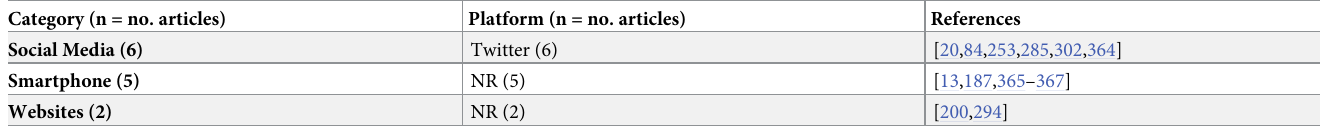
Table 17. Number of articles predicting income, with associated platforms and references. Category (n = no. articles)